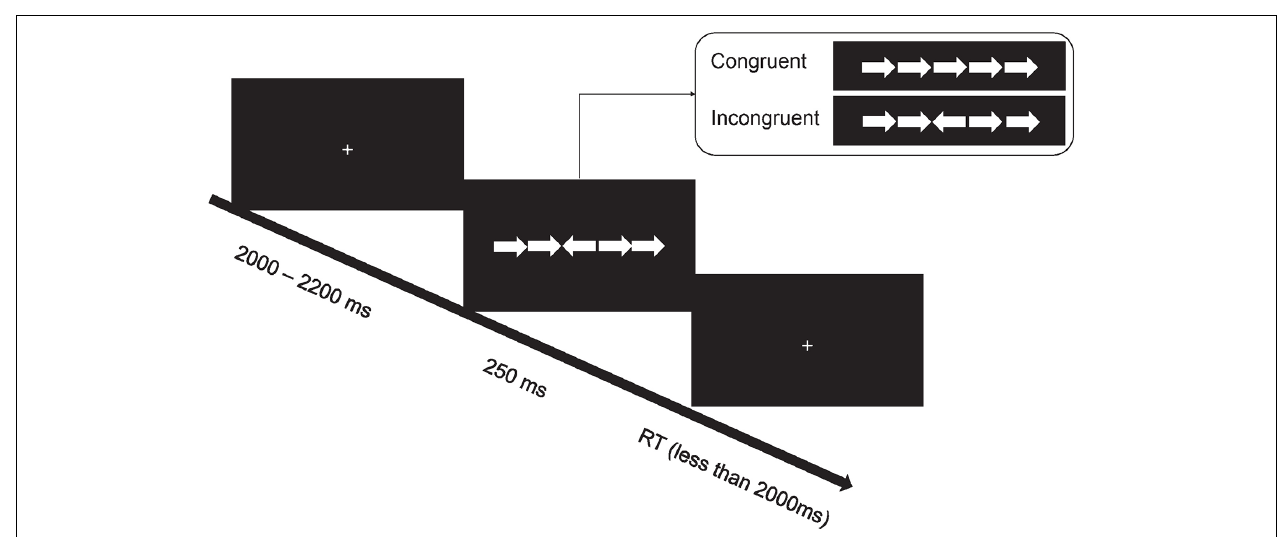
FIGURE 1 | The schematic diagram of the Eriksen flanker task.